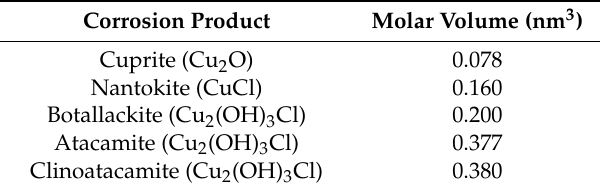
Table 8. Molar volume of the different phases that usually form on copper when exposed to marine atmospheres